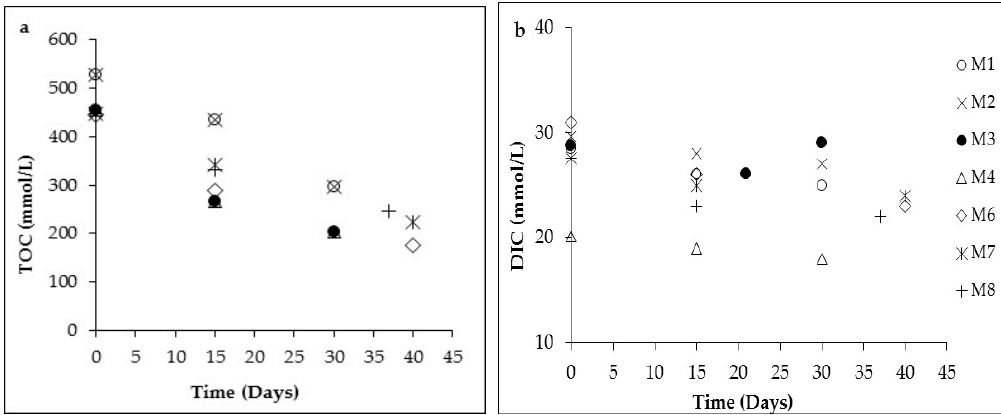
Figure 4. Evolution of total organic carbon (TOC) ( a ) and dissolved inorganic carbon (DIC) ( b ) during the precipitation experiments.